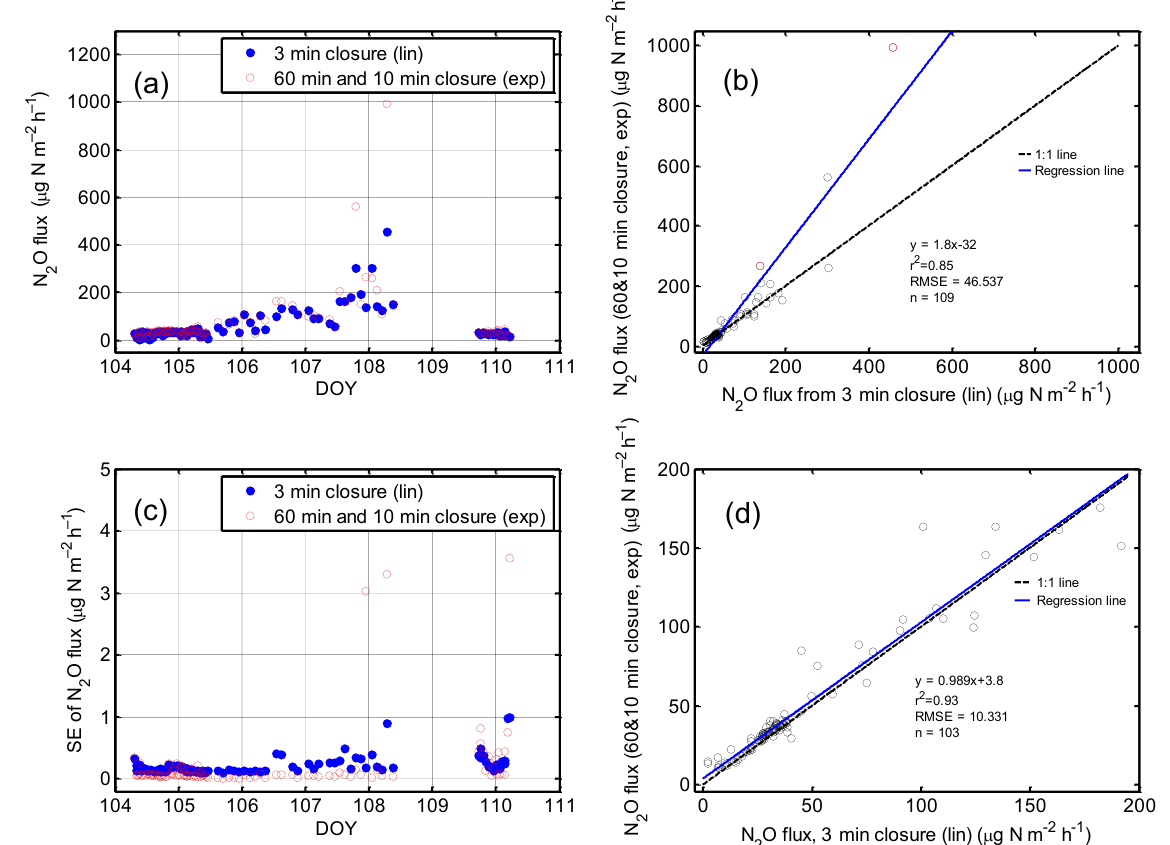
Figure 4. (a) Comparison of N 2 O fluxes measured on a harvested willow field during the Risø campaign by the QCL system based on a linear model using only the first 3min of data after chamber closure (filled blue circles) and an exponential model (open red circles) (see text) using either the full 60min (DOY 105.5 to 108.5) or the full 10min of data (DOY <105.5 and >108.5). (b) Linear regression analysis of N 2 O fluxes from the exponential vs. the linear model. Red circles indicate fluxes where the underlying concentration data showed an unusual pattern with a steady linear start followed by a sudden relatively sharp bend with a lower linear increase afterwards (see Sect. 4.2 for details). (c) Standard errors of fluxes shown in (a) . (d) Same as (b) , but only for fluxes <200µg Nm − 2 h − 1 with adapted